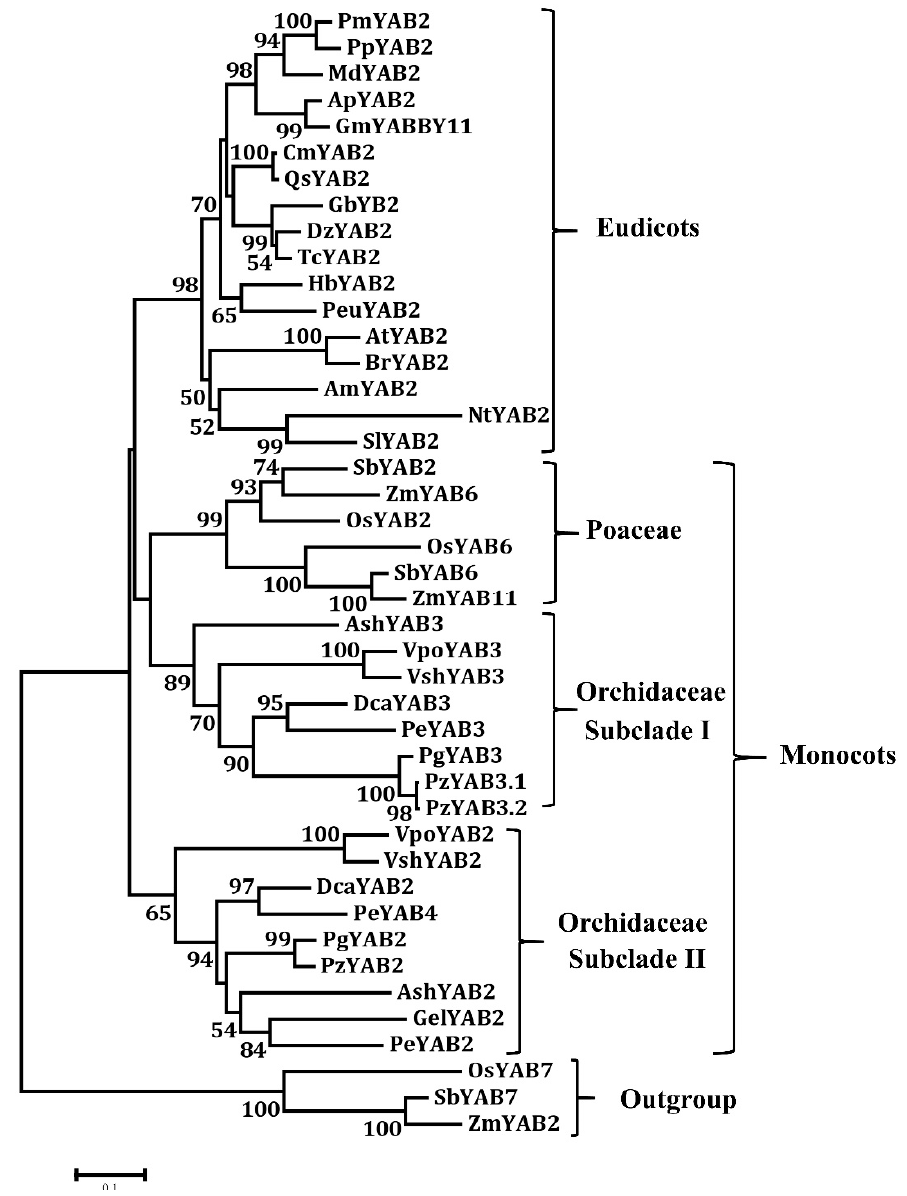
Figure 6. Phylogenetic tree of the YAB2 protein from the angiosperms. The phylogenetic tree was constructed with the neighbor-joining (NJ) method in MEGA 6.0 software. A bootstrap analysis was conducted with 1000 replications. The protein accession numbers for the related proteins are listed in Supplementary Table S1.